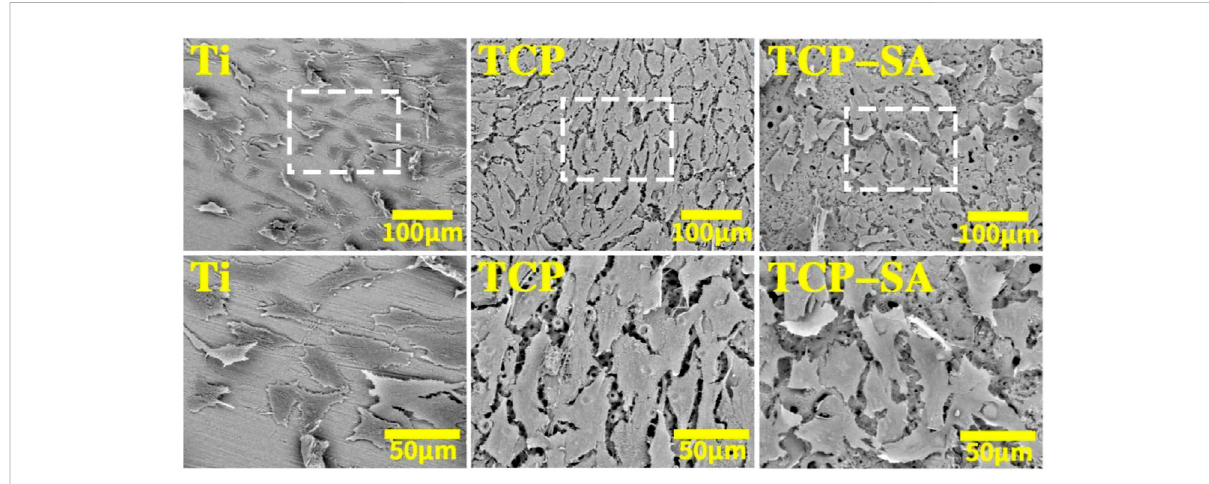
FIGURE 8 SEM results showing cells spread on different sample